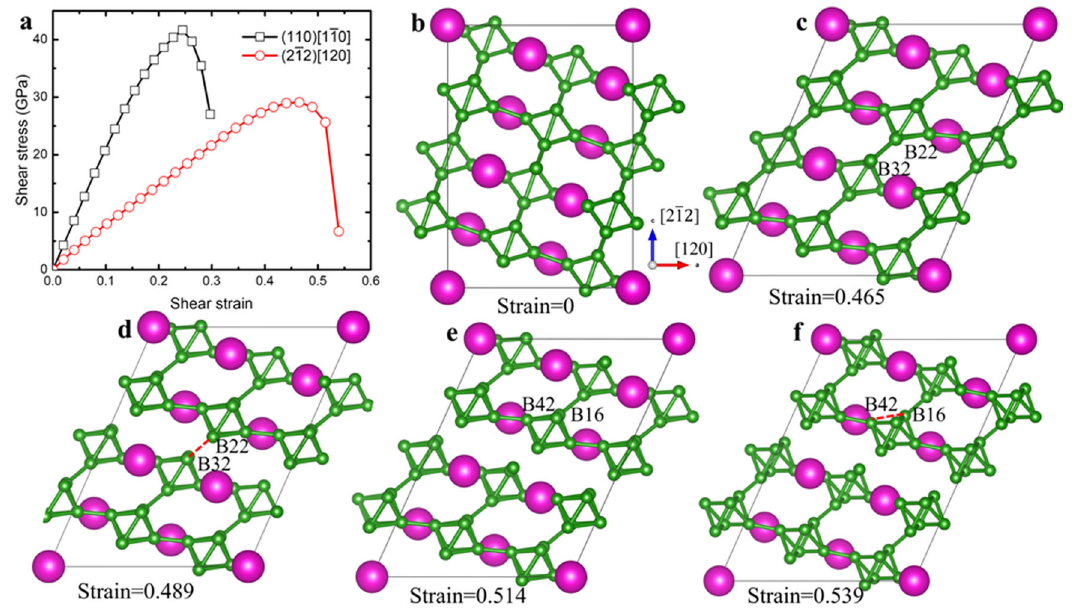
Fig. 4 The deformation and failure process of EuB 6 under pure shear deformation. a The shear-stress-shear-strain relationship along both (2 (cid:1) 12)[120] and (110)[1 (cid:1) 10] slip systems. b – f The failure process along (2 (cid:1) 12)[120]: b the intact structure; c the structure at 0.465 strain before structural failure; d the structure at 0.489 strain in which B22-B32 bond breaks; e the structure at 0.514 strain; f the structure at 0.539 strain in which the B16-B42 bond breaks, initiating the deconstruction of octahedron. The green and magenta balls represent the B and Eu atoms, respectively.